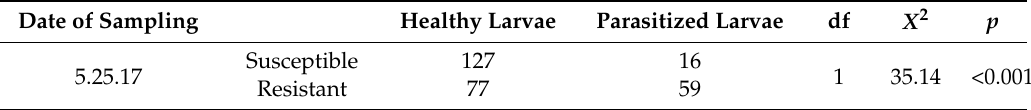
Table 4. Number of parasitized larvae in 24 susceptible and red salernitan ecotype (RSE) galls. X 2 contingency table